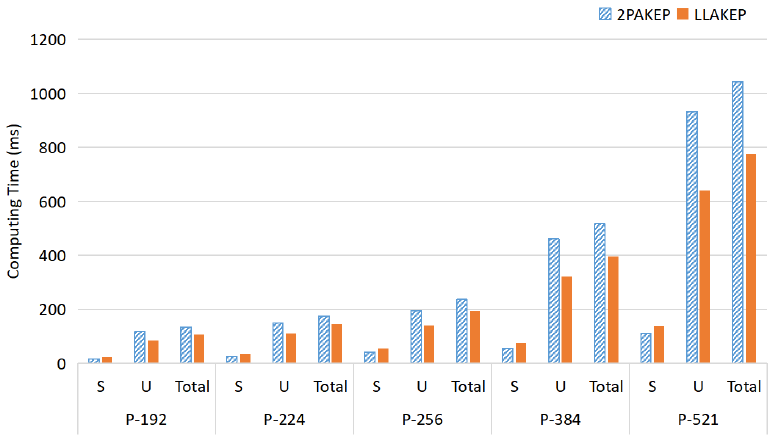
Figure 4. Average computing time in Experiment II. The experiment uses a Raspberry Pi to represent the smart glasses and a laptop to represent the energy device. The results are as follows: (1) the calculation time on the U side using LLAKEP is less than 2PAKEP; (2) the total calculation time of LLAKEP is less than 2PAKEP.